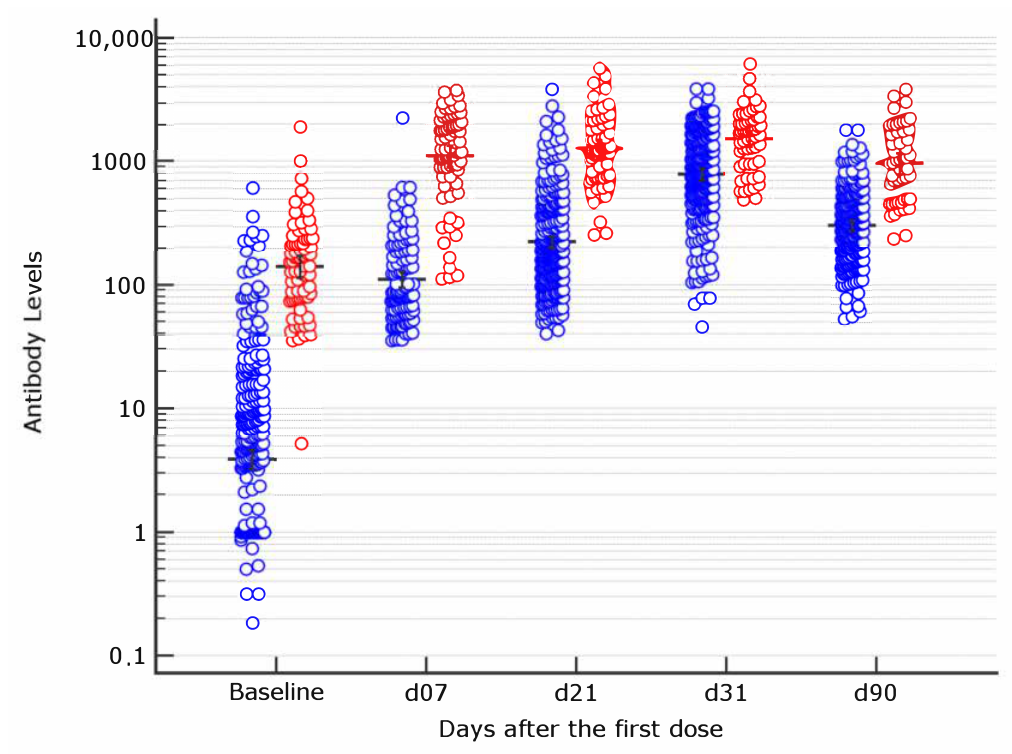
Figure 1. Antibody levels in COVID-19 naive (blue) and COVID-19 experienced (red) at the different time points for subjects with results higher than the positivity threshold of the assay. Geometric mean and 95% Confidence Intervals are reported (statistical significance is shown in Table 1). The highest threshold of the assay is 35,200